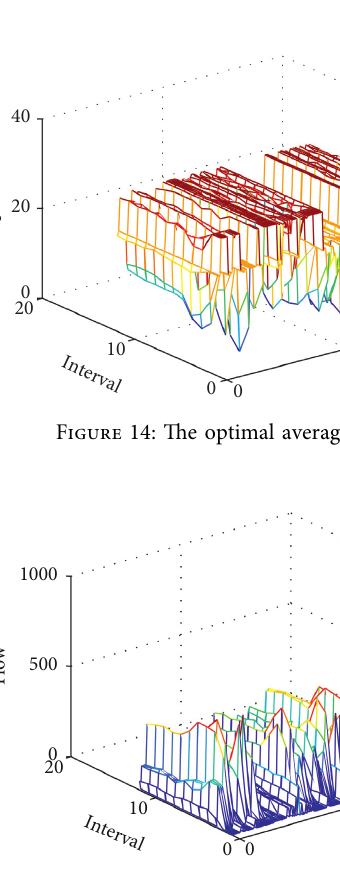
Figure 13: The optimal averaged density.